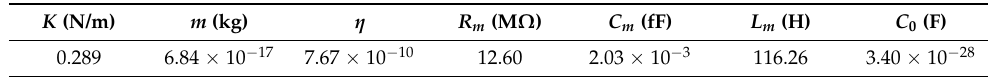
Table 2. Solution results of equivalent circuit model